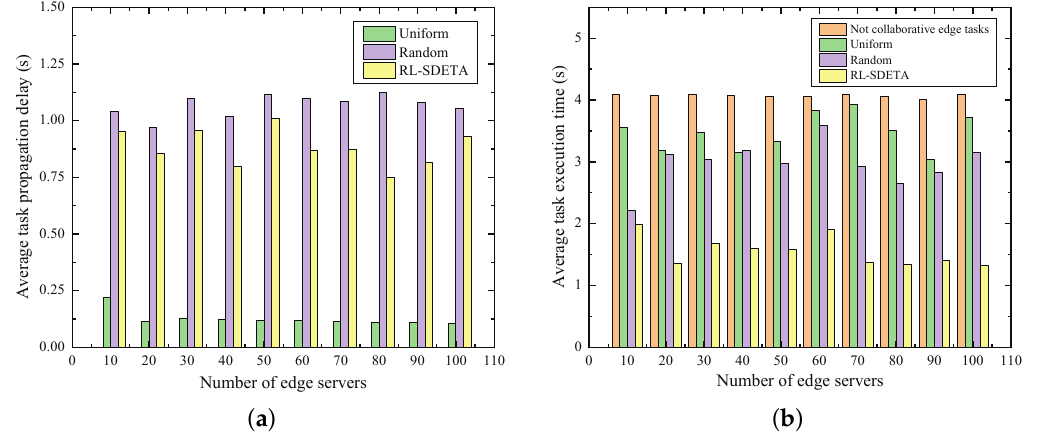
Figure 7. Effects of different task-unloading schemes on edge tasks. ( a ) Effect of task propagation delay. ( b ) Effect of task execution time.